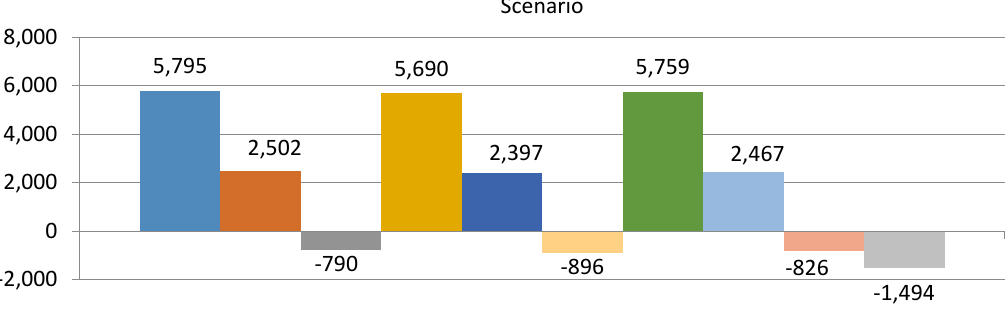
Figure 7. NPV for each scenario if the forecasting period equals five years and, in the first year, number of prosumers is 1000 and number of micro-installation owners is 20 in each year (tPLN).